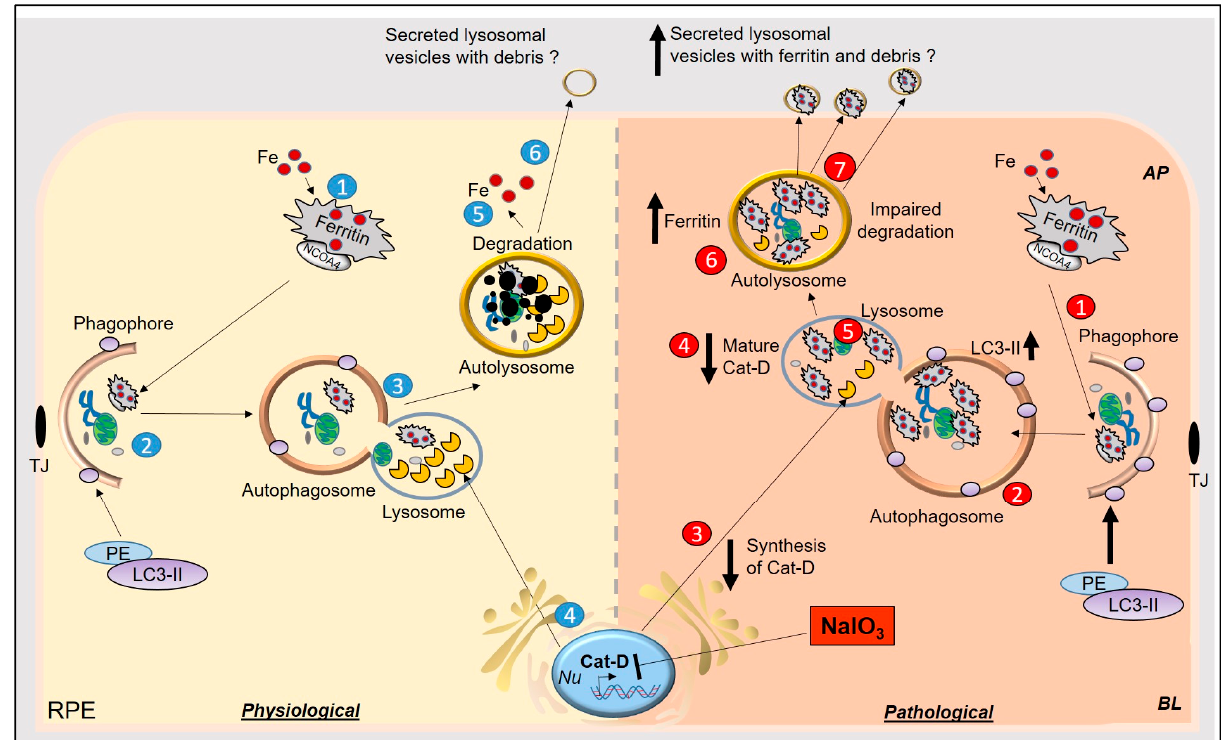
Figure 7. Graphical representation of NaIO 3 -induced model of AMD in-vitro and in-vivo. Physiological : (1) Iron-loaded ferritin is transported to the phagophore by NCOA4, (2) for degradation with the rest of the cell debris. Levels of LC3II increase with the maturation of phagophore to autophagosome. (3) Autophagosome fuses with lysosomes, (4) where lysosomal enzymes, including cat-D, degrade ferritin and cellular debris. (5) Iron from ferritin is released in the cytosol to be utilized for metabolic purposes. (6) Other debris undergoes autolysis or is secreted via an unconventional lysosomal secretory pathway to the extracellular milieu. Pathological: (1) In NaIO 3 -induced AMD, iron-loaded ferritin is delivered to the phagophore, (2) which matures into autophagosomes. Levels of LC3II are increased because of accumulation of debris in autophagosomes. (3 and 4) Synthesis and maturation of cat-D are impaired by NaIO 3 , (5) resulting in the accumulation of iron-loaded ferritin in lysosomes and (6) autolysosomes. (7) Iron-loaded ferritin is secreted in lysosomal vesicles in the extracellular milieu, which is probably internalized by the adjacent photoreceptors, resulting in iron-mediated oxidative stress.